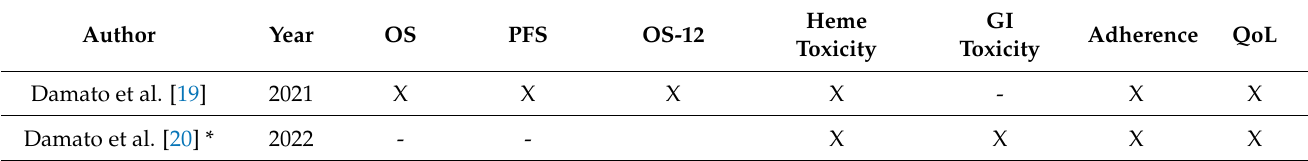
Table 3. Overview of outcomes reported in all eligible studies (OS: overall survival; PFS: progression- free survival; OS-12: overall survival at 12 months; GI: gastrointestinal; QoL: quality of life; X: reported; -: unreported). * Campian et al. [21] and Atluri et al. [22] report the pre-publication results of this completed